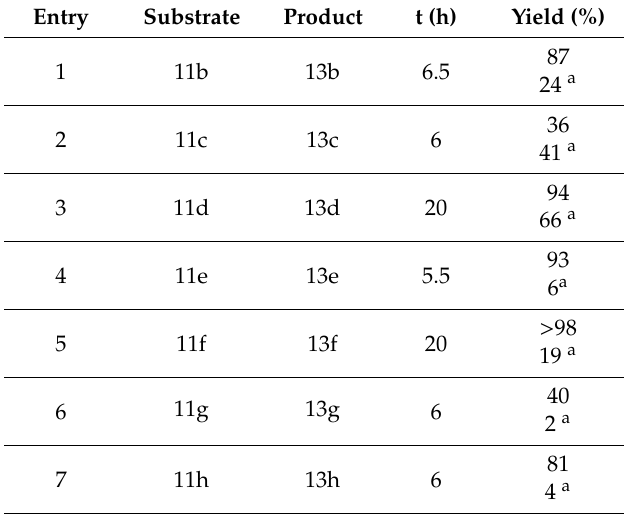
Table 3. 1H tetrazoles 13b – h synthesis mediated by hexameric capsule 2 .